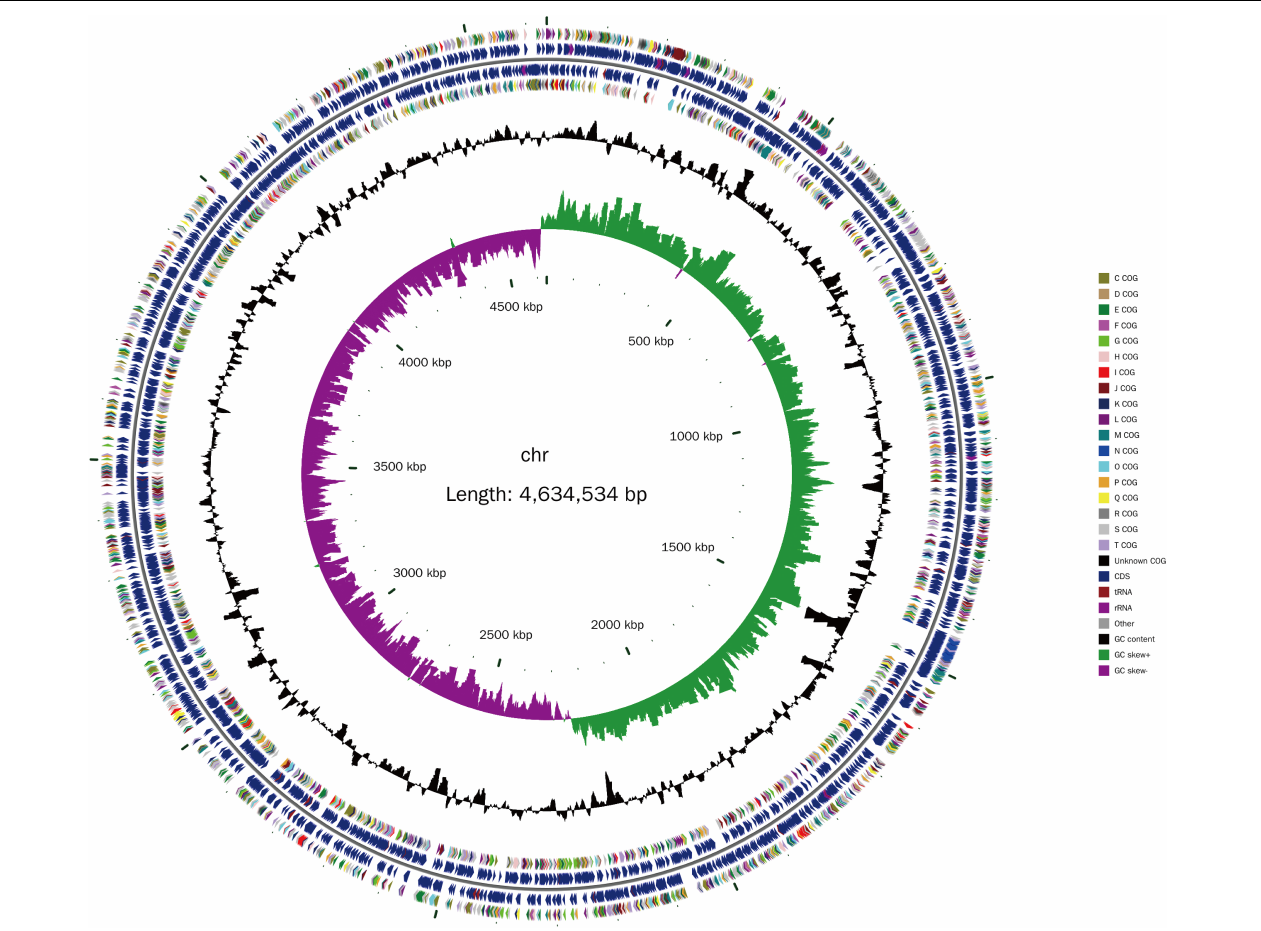
FIGURE 1 | The genome structure of Lzh-2. The inner circle is the scale label. The second circle represents the GC skew (green positive, purple negative). The third circle represents the GC content. The 4th and 7th circles represent the COG classification. The 5th and 6th circles represent the genes identified. Different colors denoted the COG